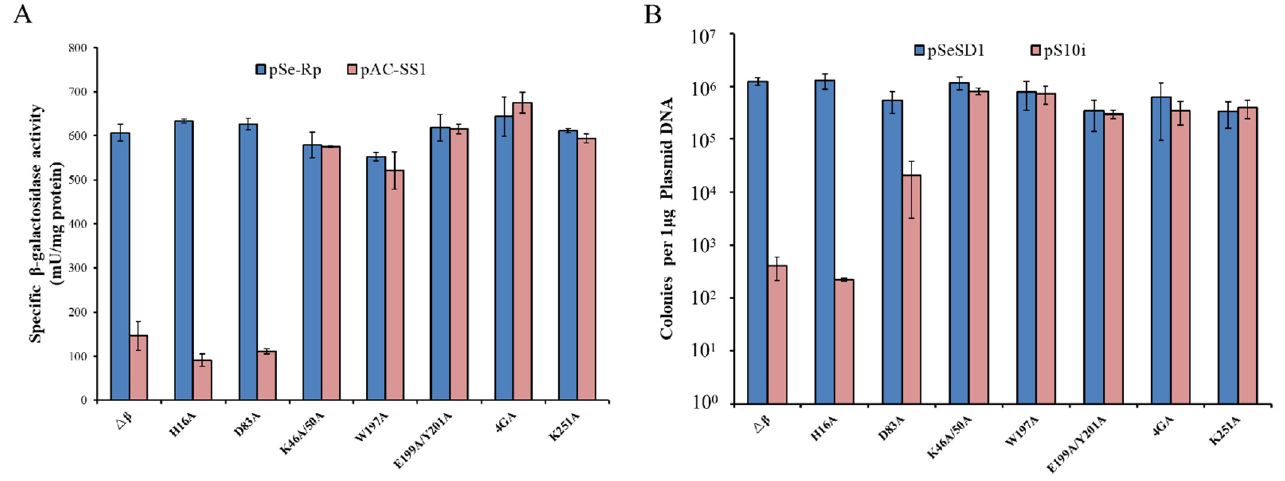
Figure 4. Function of Cmr4 α conserved amino acids in the Cmr- α immune system. ( A ) In vivo RNA interference activity in the cmr4 α mutant strains determined by artificial mini-CRISPR-based reporter gene assay. The chromosomal lacS gene was used as the reporter gene. pSe-Rp: reference plasmid; pAC-SS1: an artificial mini-CRISPR plasmid carrying S1 spacer of the lacS gene. ( B ) Invading plasmid silencing activity of the cmr4 α mutant strains. pSeSD1: the reference plasmid; pS10i: an invading plasmid carrying a target sequence of spacer 10 in CRISPR locus 2 in S. islandicus REY15A; Δβ : the wild-type strain; other strains: mutants carrying the specified point mutation of Cmr4 α ; 4GA: G244AG245AG250AG252A substitutions.